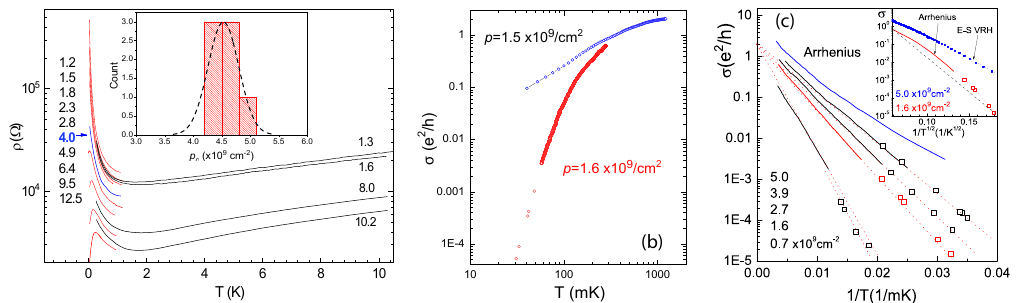
Figure 2. ( a ) T dependence of the resistivity ρ ( T ) for a carrier density range from 7 × 10 8 cm − 2 to 1.25 × 10 10 cm − 2 . ( b ) Comparison of the nonactived conductance (in blue) of a clean system to the activated hopping conductance (in red) of a more disordered system for p ∼ 1.5 × 10 9 cm − 2 . ( c ) The nonactivated behavior is turned into an activated behavior as a result of increase of disorders. p is from 7 × 10 10 cm − 2 to 5 × 10 9 cm − 2 . Solid lines are the AC results and the scattered points are the DC results. Dotted lines are a guide to the eye. Inset: comparison between an Arrhenius hopping and the Efros-Shklovskii variable range